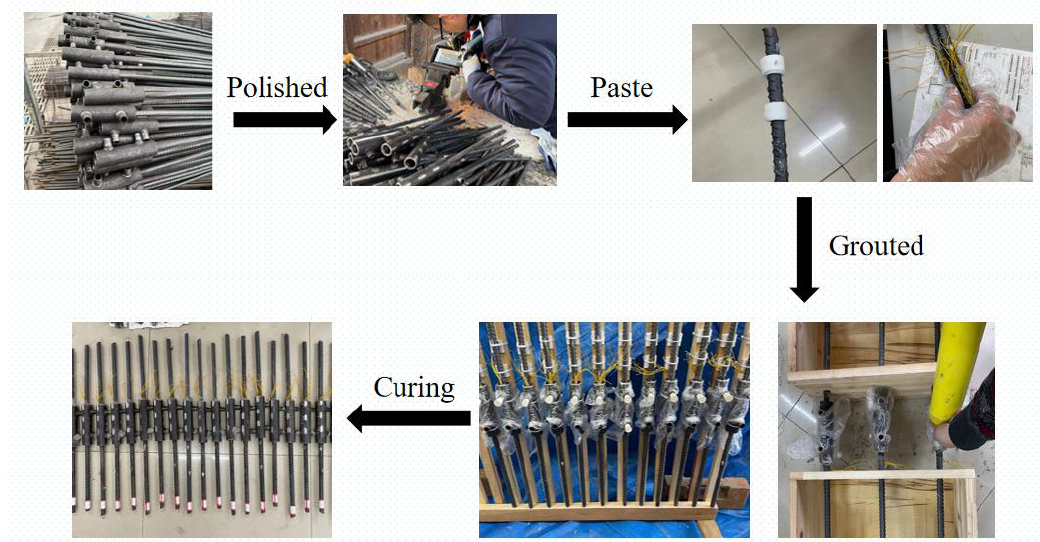
Figure 8. Production process of specimen.